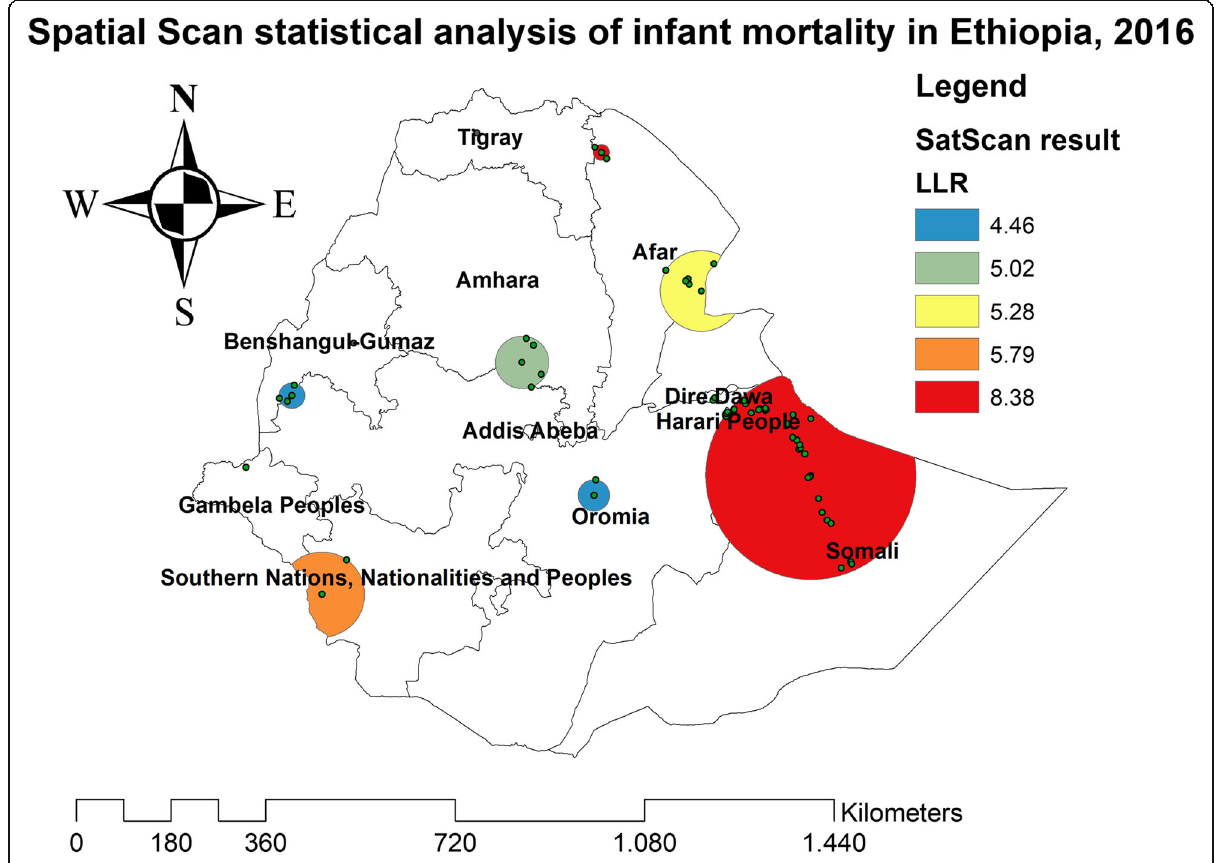
Fig. 5 The SaTScan analysis of infant mortality in Ethiopia in 2016